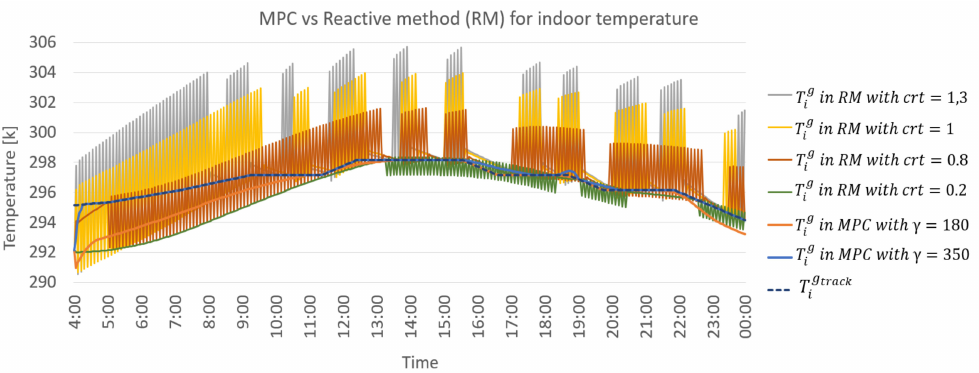
Figure 12. MPC vs. the reactive method performances in comparison with respect to the tracking of the indoor temperature T g Thus, to evaluate the tradeoff between energy saving ( OBJ 2) and tracking costs ( OBJ 3) in the MPC approach, the parameter γ in Equation (1d) was modulated, while, in the reactive method, the parameter crt in Equation (12) was varied according to the range of feasible values. The resulting Pareto optimal solutions in Figure 13 shows that the reactive control was dominated by the MPC